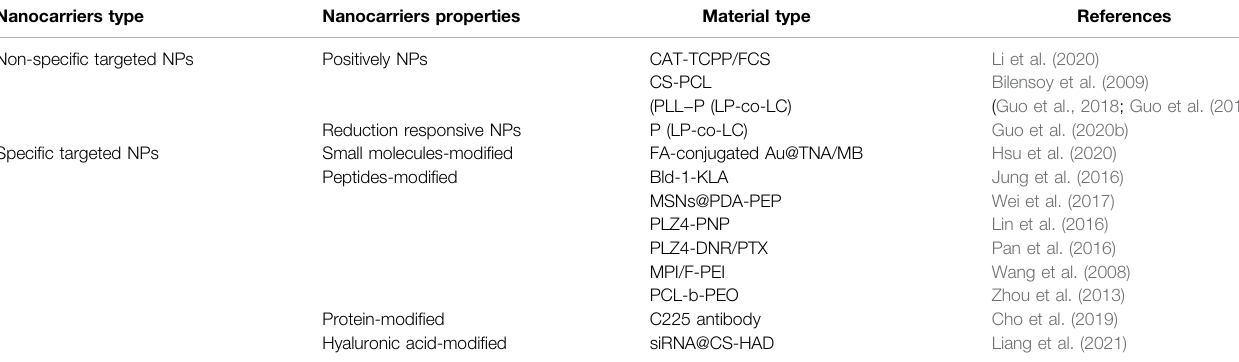
TABLE 1 | The mechanism of non-speci fi c and speci fi c targeted therapeutic nanocarriers for treatment of cancer. Nanocarriers